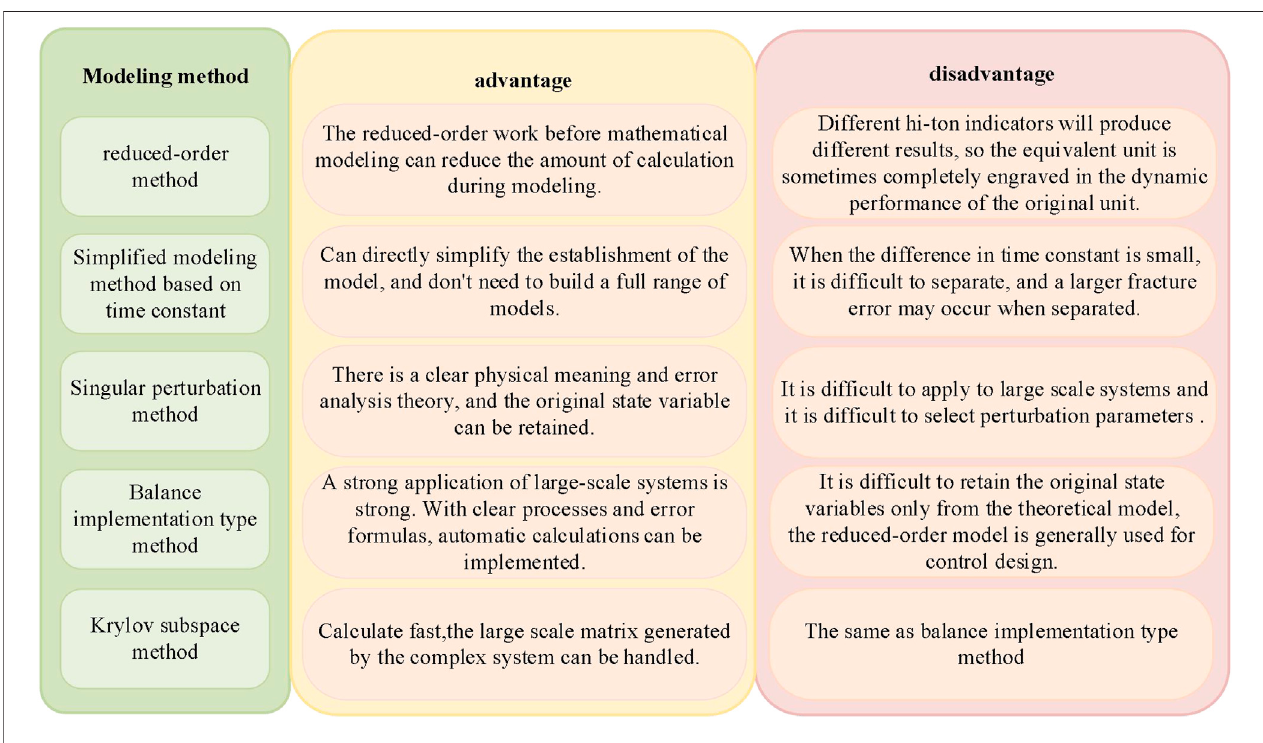
FIGURE 5 | The advantages and disadvantages of the main reduction